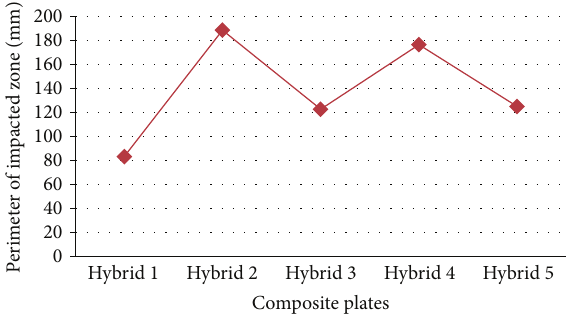
Figure 10: Comparison of the energy absorption and different final velocities of six specimens at 182m/s as the initial